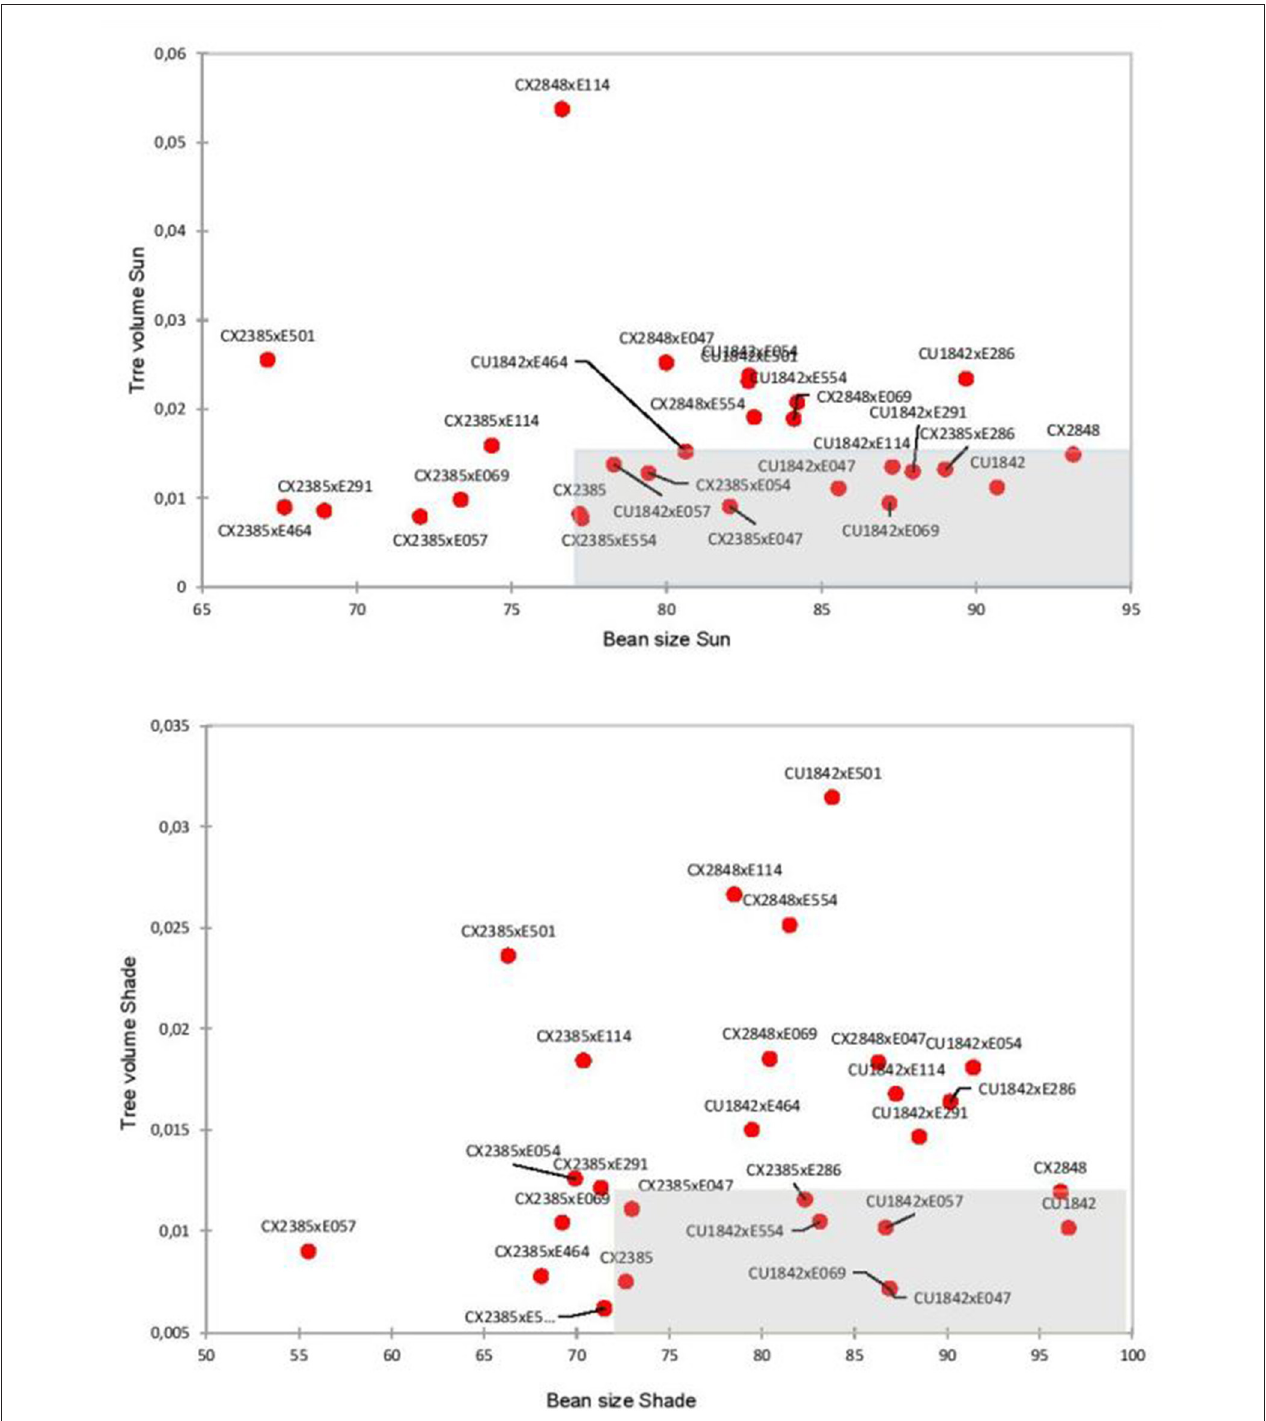
FIGURE 2 | Selection for a “full-sun” farming system. Scatterplots showing tree volume and bean size. The F1 hybrid population and the population of female lines (three components of cv. Castillo) are represented. The genotypes inside the rectangle were selected because they produced similar performances in terms of tree volume and bean size to those of the maternal lines. Upper graph, selection in the full-sun plot, lower graph, in the shade plot.